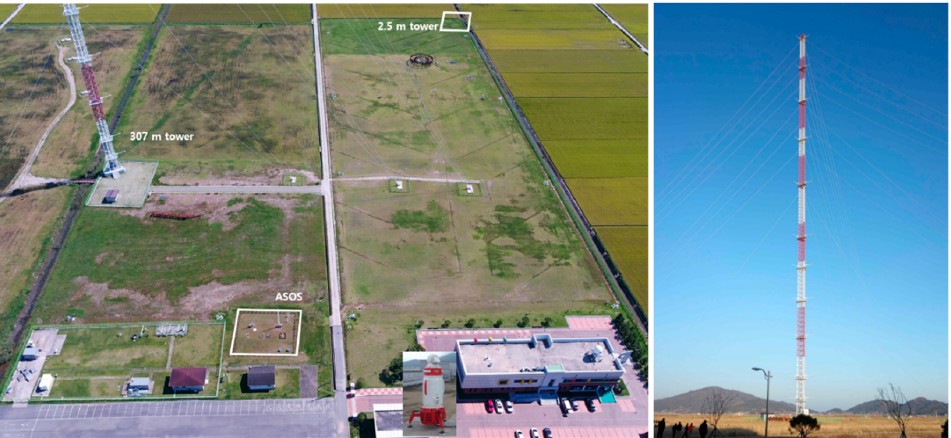
Figure 2. ( Left ) Bird’s eye view of BMO (In this photo, north is on the left and south is on the right), and ( Right ) the 307 m meteorological tower established at BMO. Four 3D sonic anemometers are mounted at 60 m, 140 m, and 300 m above the ground, on the northeastern side of the observation boom. Additionally, a 3D sonic anemometer is installed at 2.5 m above the ground located to the southeast of the tower (white box at the top of the left photo). An automated surface observing system (ASOS) is also located in BMO (white box at the bottom of the left photo).